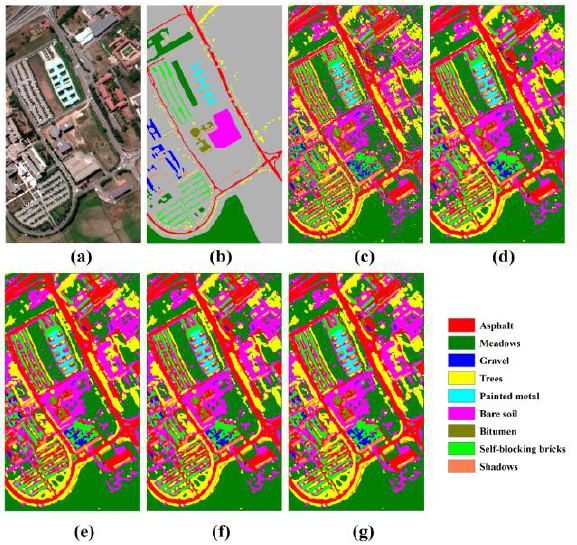
Figure 4. Pavia University image and its classification results: (a) false color composite of the Pavia University image; (b) reference map; (c) OCM; (d) CM_Distance; (e) CM_Eastman’s U; (f) CM_Entropy; (g) CM_Proposed.